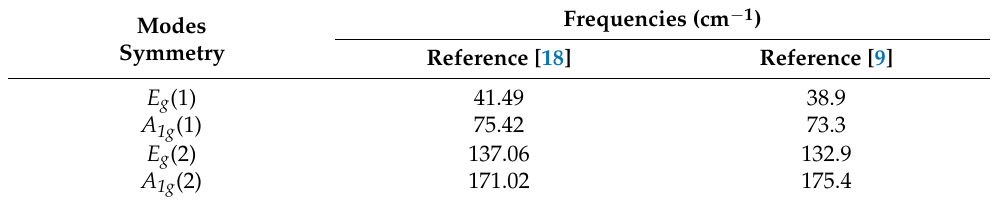
Table 1. Raman shifts of the different modes of symmetry for Bi 2 Se 3 . Modes